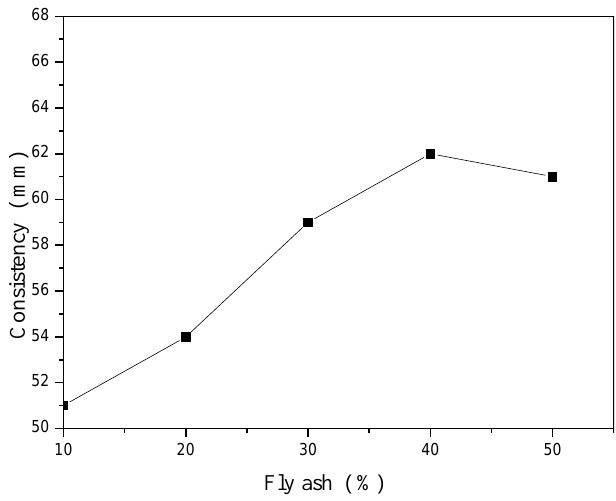
Figure 4. Effect of fly ash on the consistency of the mortar. Figure 5a shows the relationship between the compressive strength of the mortar test block at 28 days and the content of fly ash. When the content of fly ash increased from 10% to 20%, the strength of the mortar decreased the most, indicating that a small amount of fly ash had a great influence on the compressive strength of the mortar. The reason is that the hydration rate of fly ash is slow, and the total amount of hydration products in the system was small [40,41]. When the content of fly ash was increased, the amount of cement with higher brittleness was correspondingly reduced. This reduced the compressive strength-to- flexural strength ratio of the mortar, and improved the toughness. Gao et al. [42] used the method of combining nanoindentation and scanning electron microscopy, and concluded that the addition of fly ash can reduce the elastic modulus of the microstructure of the mortar. This conclusion was also proven through macroscopic experiments. However, when the content of fly ash was too high, the negative effect of fly ash on the flexural strength of mortar increased, and the ratio of compressive strength-to-flexural strength ratio started to increase, as shown in Figure